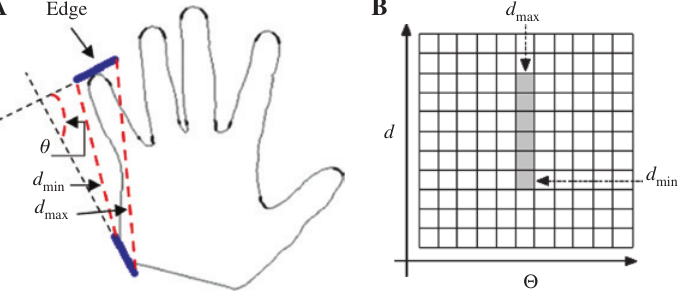
Figure 6: Spatial Feature Extraction. (A) Computation of distance and angle values from a pair of edges. (B) Construction of PGH and extraction of minimum and maximum